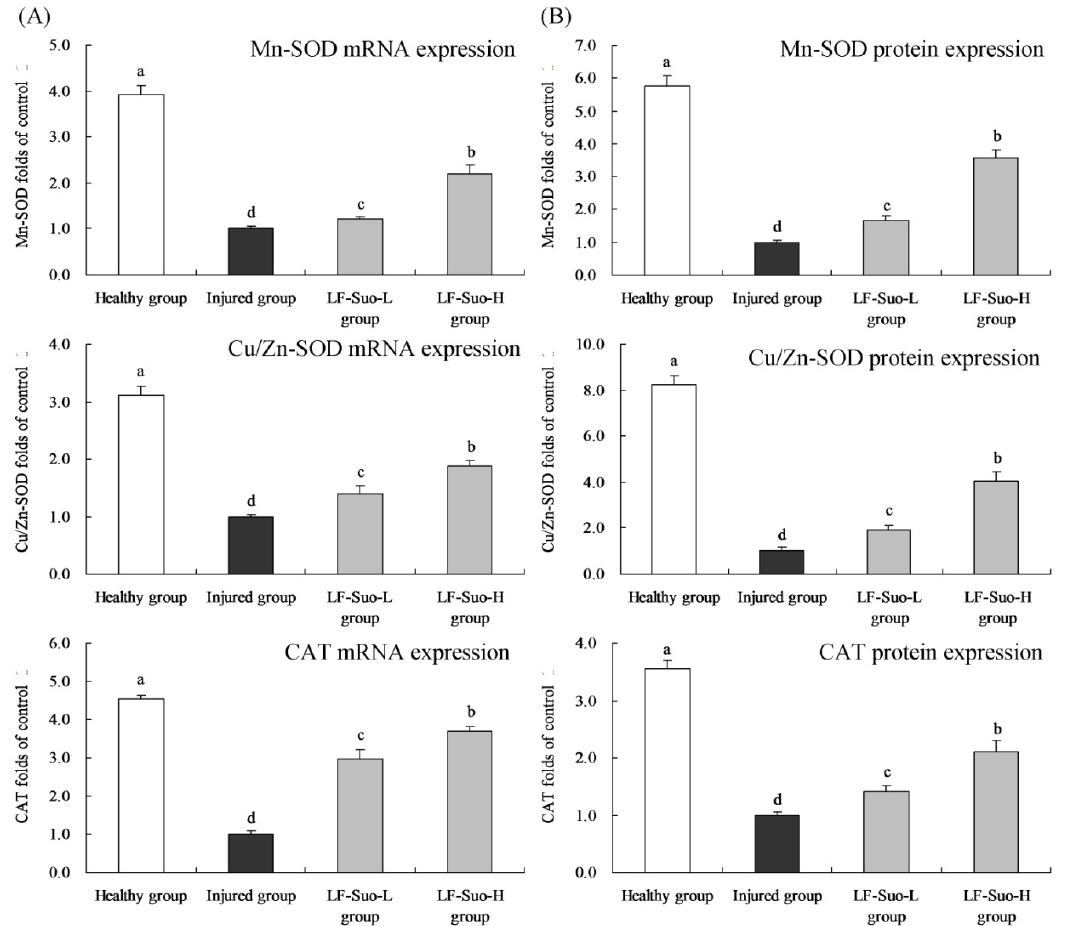
Figure 7. Mn ‐ SOD, Cu/Zn ‐ SOD, CAT mRNA ( A ) and protein ( B ) expression of studied mice. Fold ‐ ratio: gene expression/GAPDH ( β‐ actin) × injured group numerical value (injured group fold ratio: 1). a–d Mean values with different letters in the same column are significantly different ( p < 0.05) according to Duncan’s multiple ‐ range test. LF ‐ Suo ‐ L, Lactobacillus fermentum Suo (0.5 × 10 9 CFU/kg b.w.); LF ‐ Suo ‐ H, Lactobacillus fermentum Suo (1.0 × 10 9 CFU/kg b.w.).